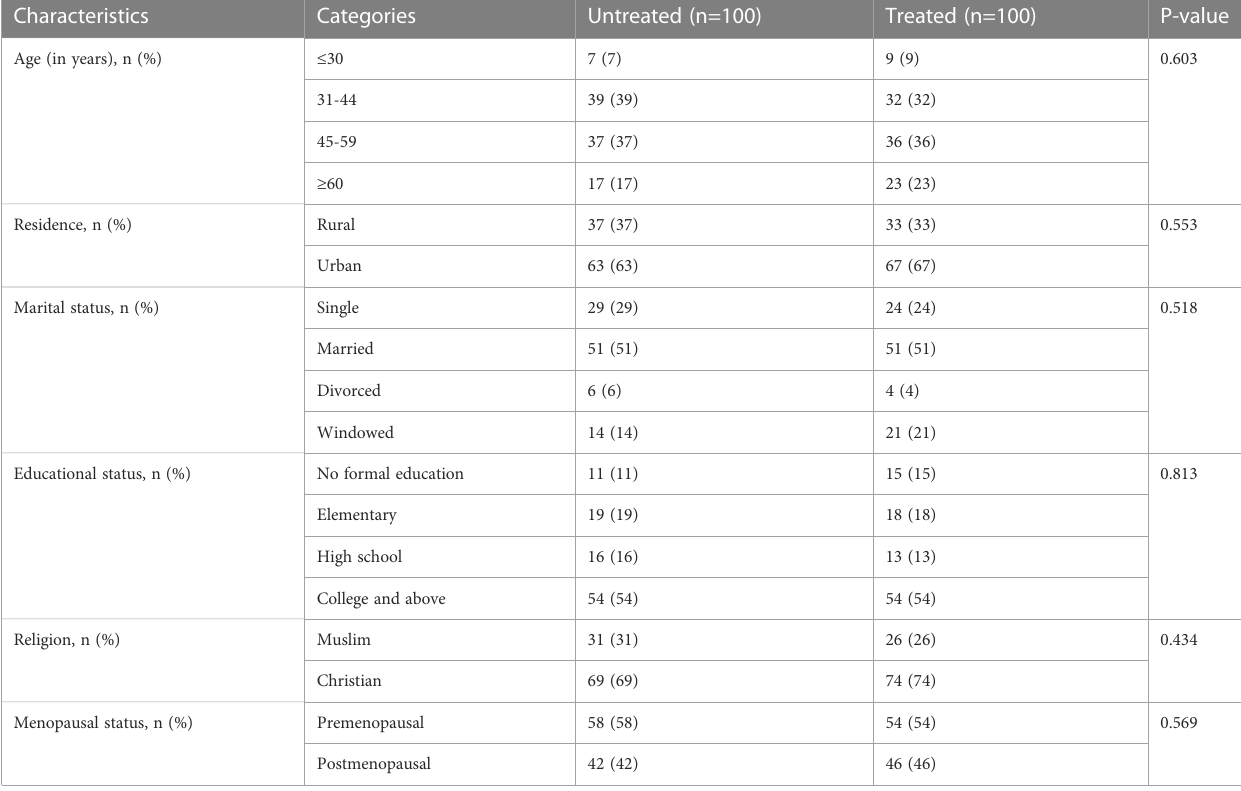
TABLE 1 Socio-demographic characteristics of AC-treated and untreated BC patients.